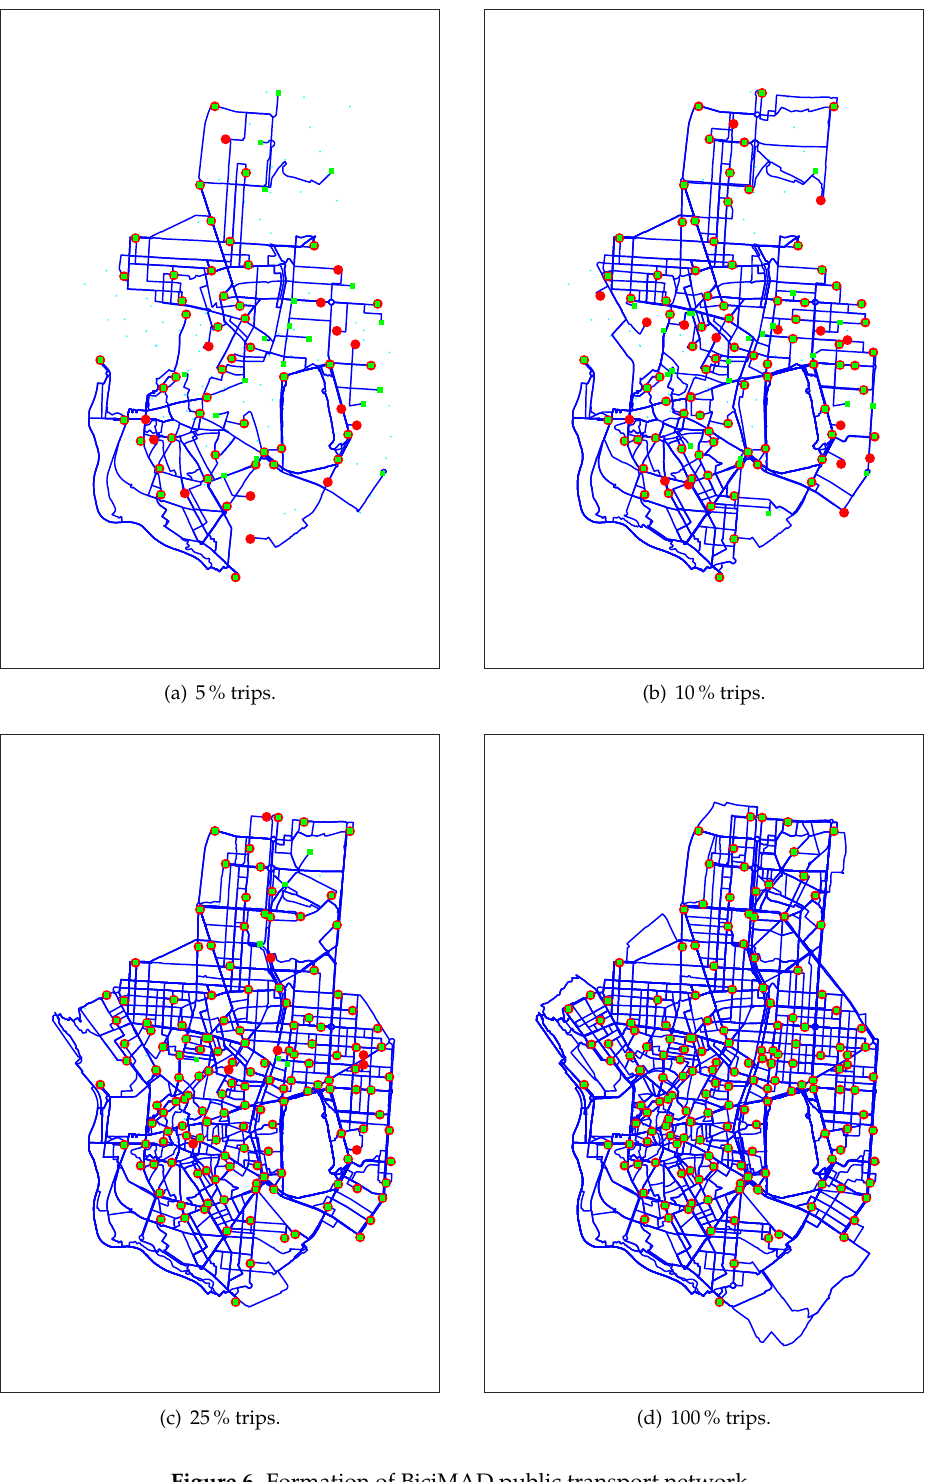
Figure 6. Formation of BiciMAD public transport